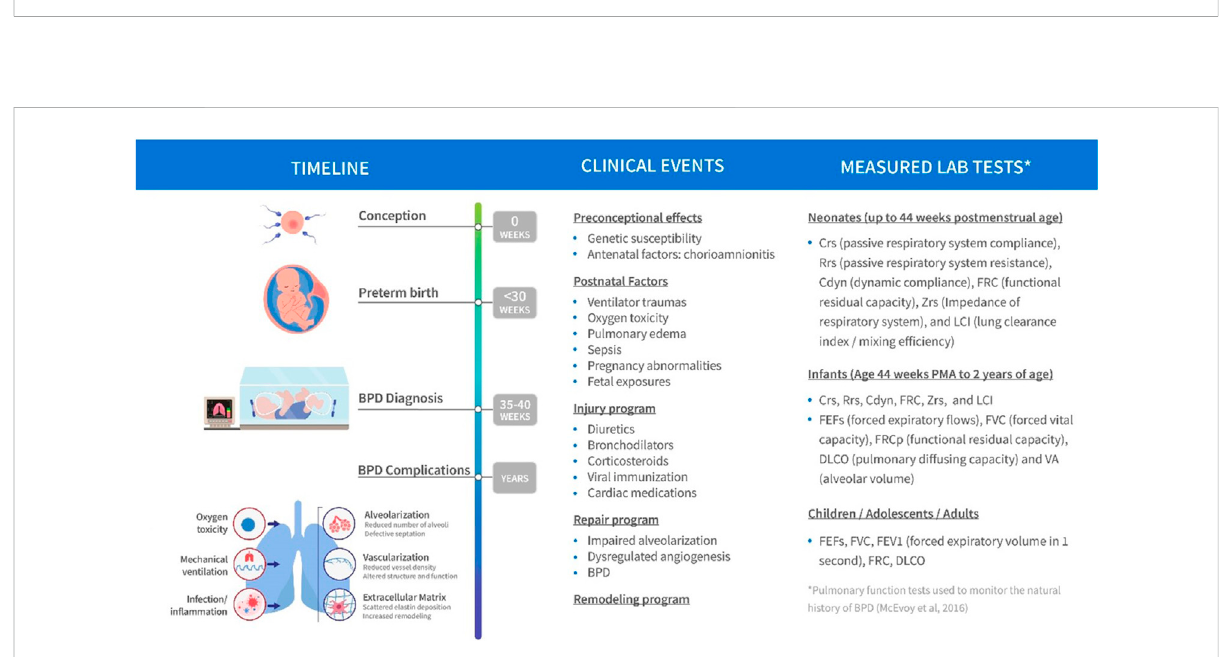
FIGURE 2 Schematic of BPD disease progression with variables of clinical interest linked to stage of